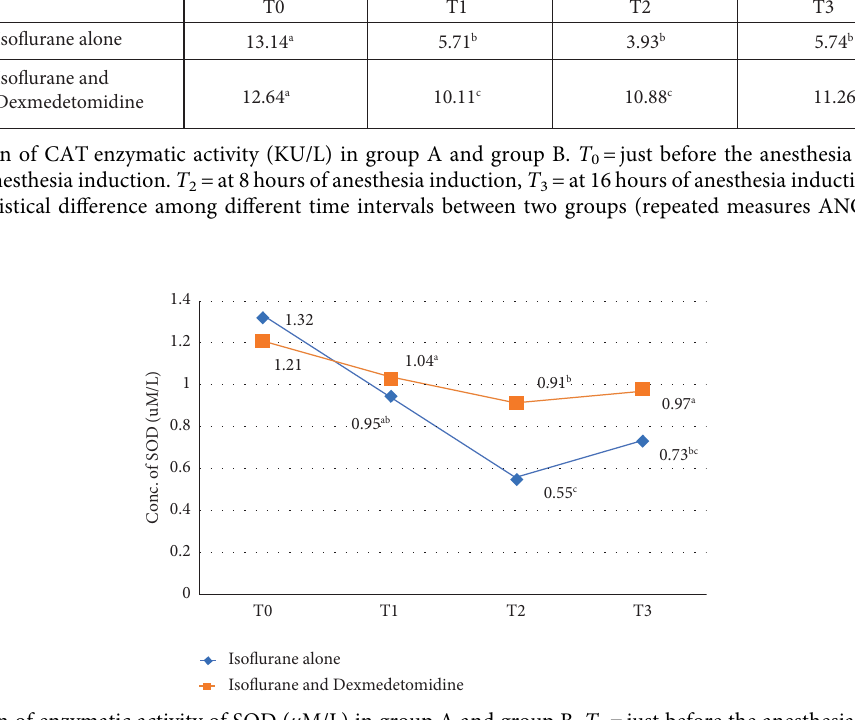
� just before the anesthesia induction (baseline), 0